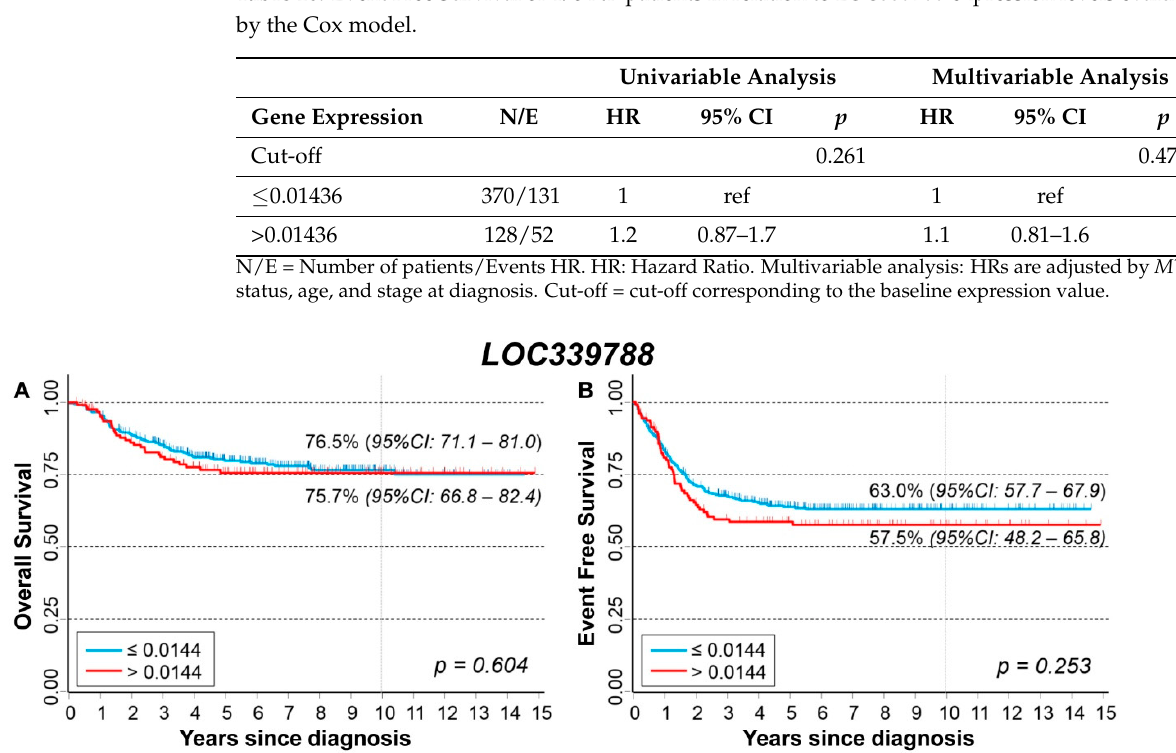
Figure 14. ( A ) Overall Survival of 498 NB patients in relation to LOC339788 expression levels. The selected cut-off is based on the baseline expression value. ( B ) Event Free Survival of 498 NB patients in relation to LOC339788 expression levels. The selected cut-off is based on the baseline expression value. Table 15. Overall Survival of 498 NB patients in relation to LOC339788 expression levels evaluated by the Cox model.